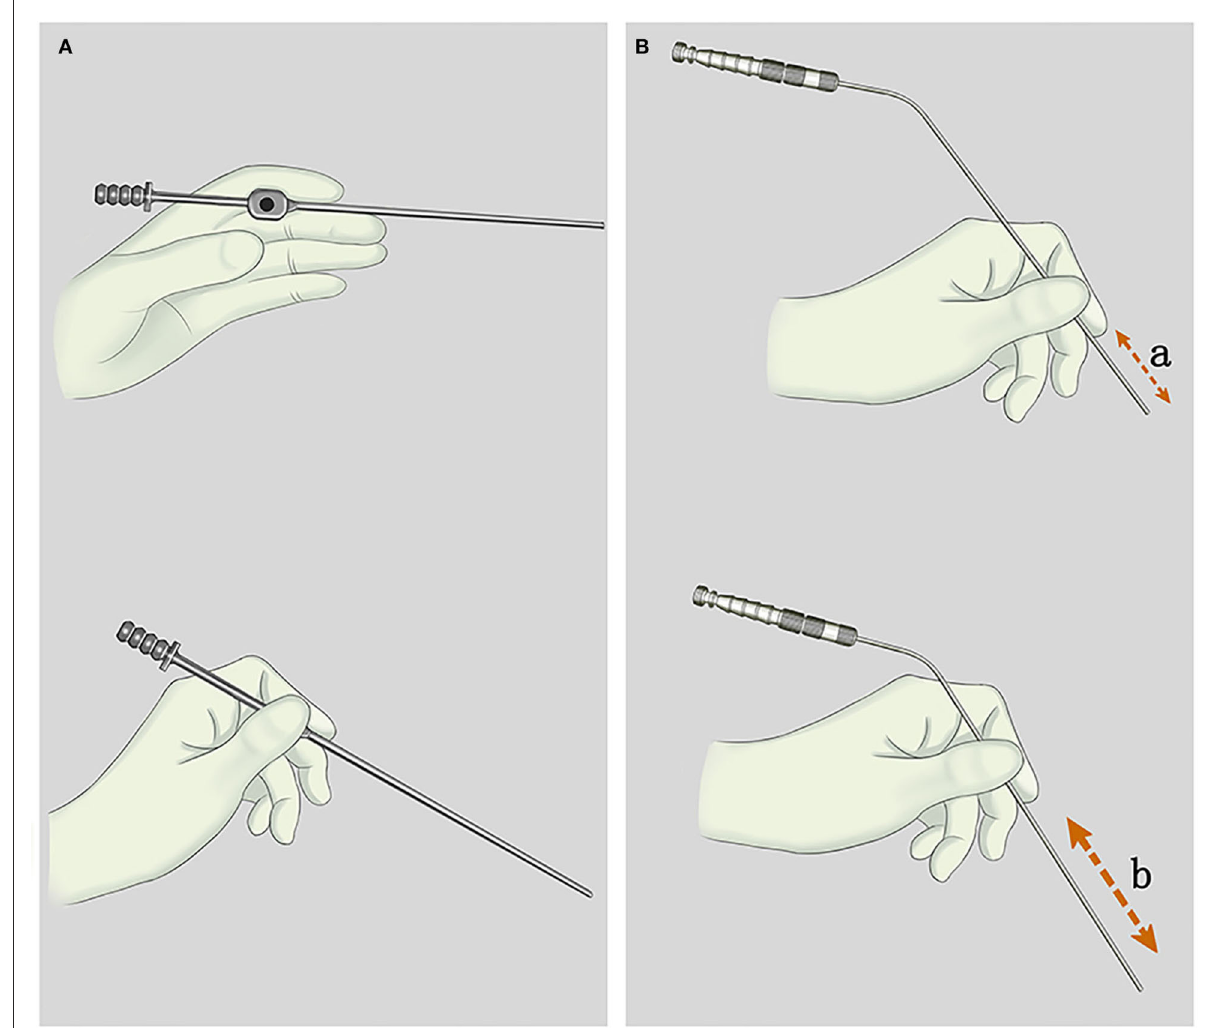
FIGURE1 (A) The style of holding the traditional suction tube. When the thumb is placed on the air inlet, the actual working distance of the suction tube is extended, which reduced the stability and accuracy of operation. (B) The style of holding an adjustable pressure suction tube (APS tube). “a and b” represent the actual working length of APS tubes, which is